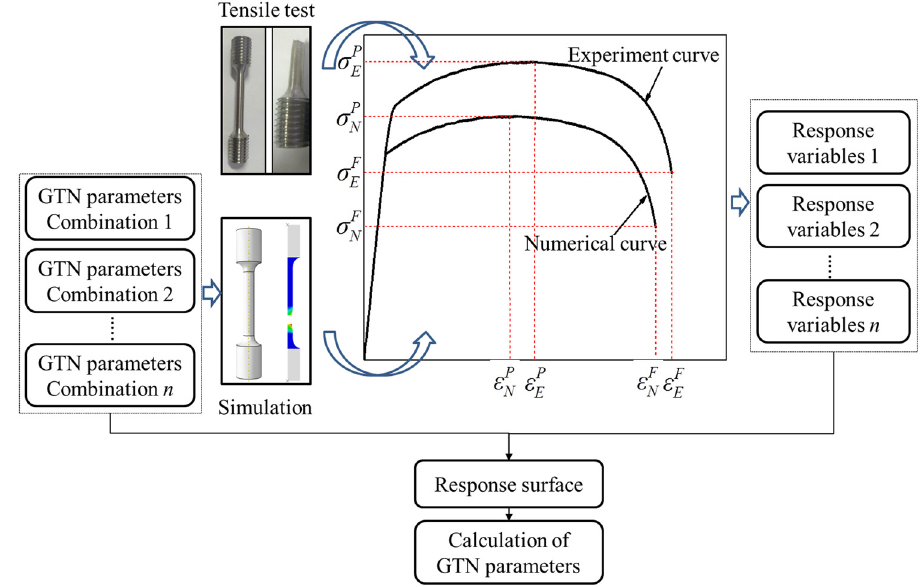
Figure 3: The solution procedures of GTN